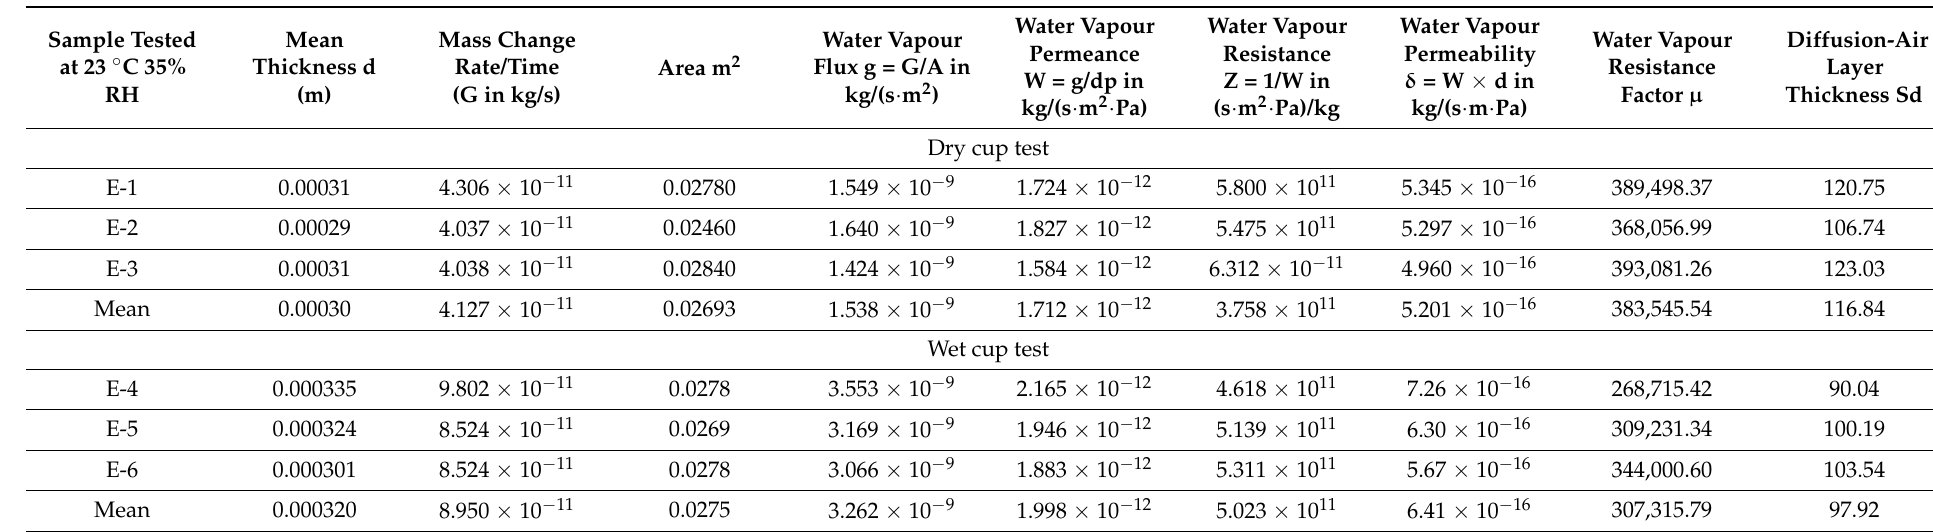
Table A10. Water vapour resistivity properties for sample E at 23 ◦ C 35%